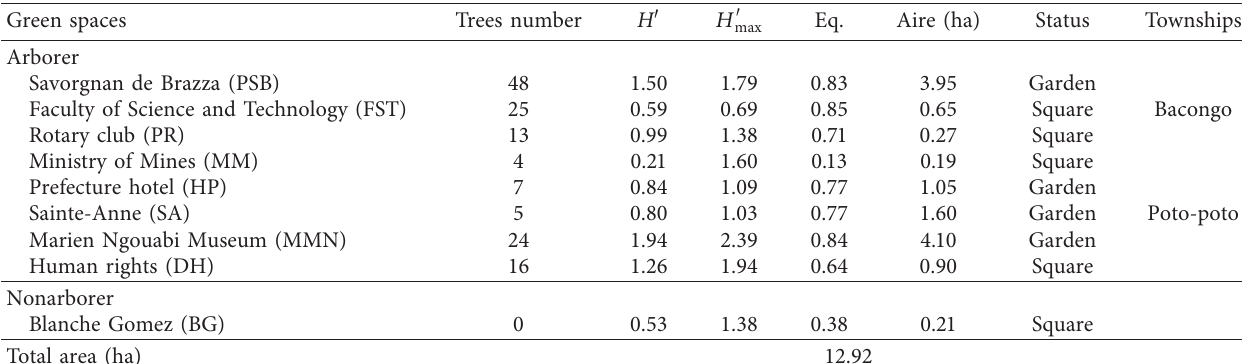
Figure 2: Climate parameter data for the Brazzaville area (source: ANAC, 2017). Ombrothermic curve (a); relative humidity and evaporation (b); insolation (c). Table 1: General data on Brazzaville green spaces and